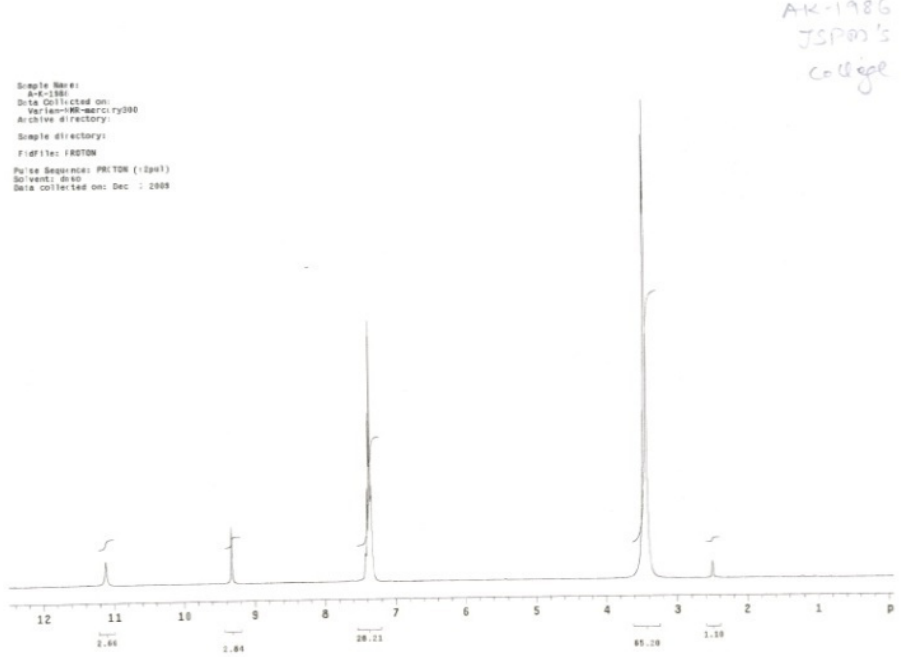
Figure 1. IR (KBr) cm -1 spectrum of synthesized phenytoin